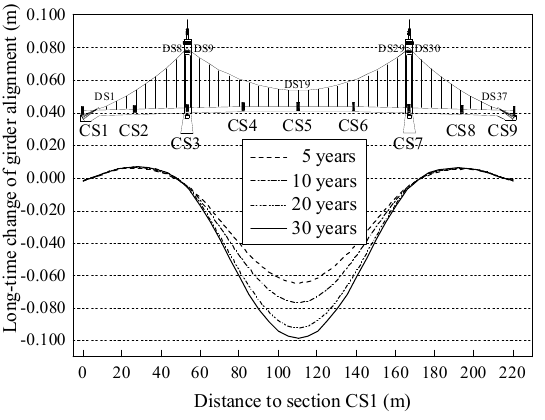
Figure 23. Predicted girder displacement.